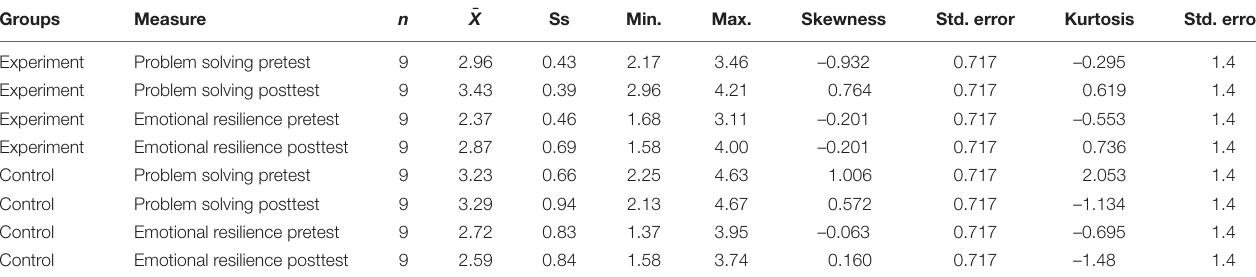
TABLE 2 | Descriptive statistics on the problem-solving and emotional resilience pretest-posttest scores of the experimental and control groups. Groups Measure n ¯ X Ss Min. Max. Skewness Std. error Kurtosis Std. error